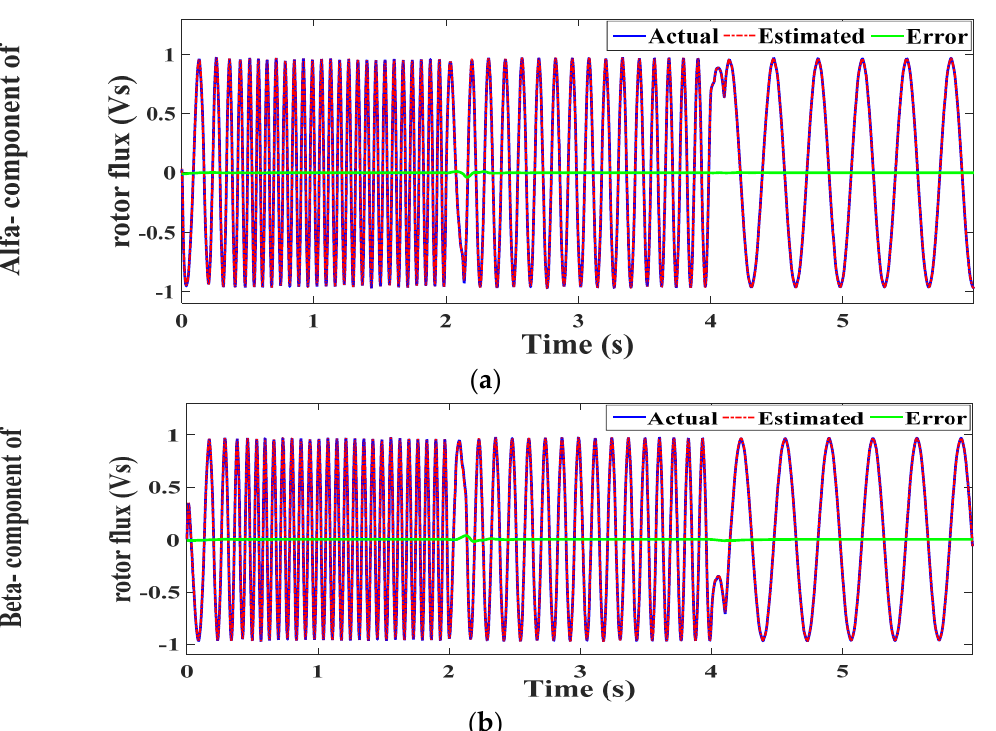
Figure 11. ( a ). Alfa-component of rotor flux under PTC approach (Vs), ( b ). Beta-component of rotor flux under PTC approach (Vs).